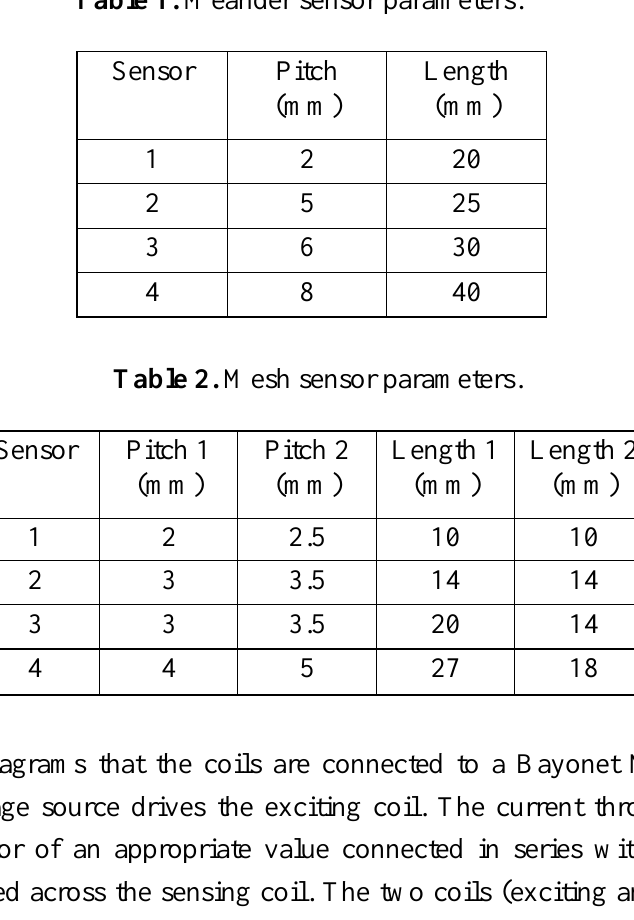
Table 1. Meander sensor parameters.